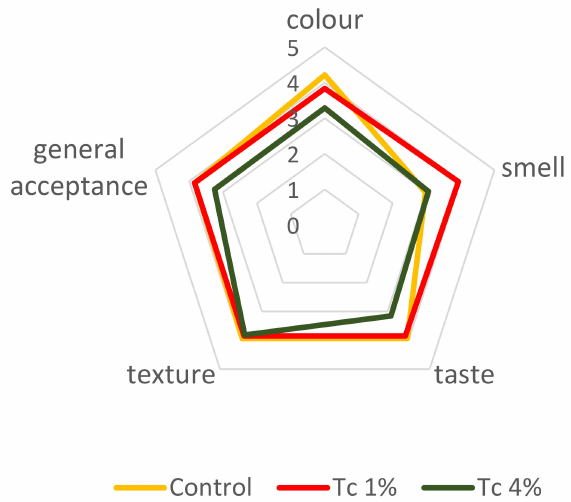
Figure 7. Responses of the sensory analysis panel tasters ( n = 32) regarding breads enriched with 1% and 4% T. chuii , as well as the control sample. 1—“very unpleasant”, 2—“unpleasant”, 3—“indi ff erent”, 4—“pleasant”, 5—“very